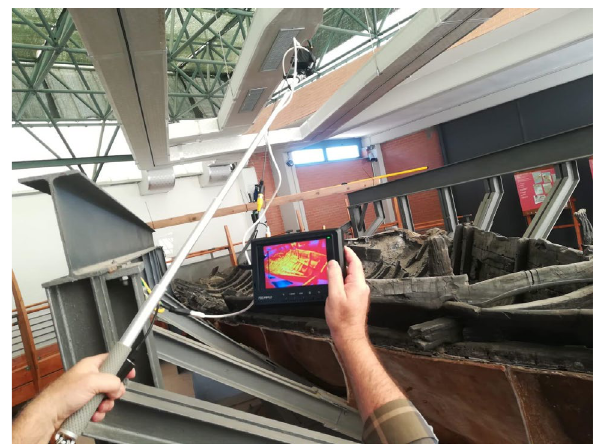
Figure 7. Thermal data-acquisition